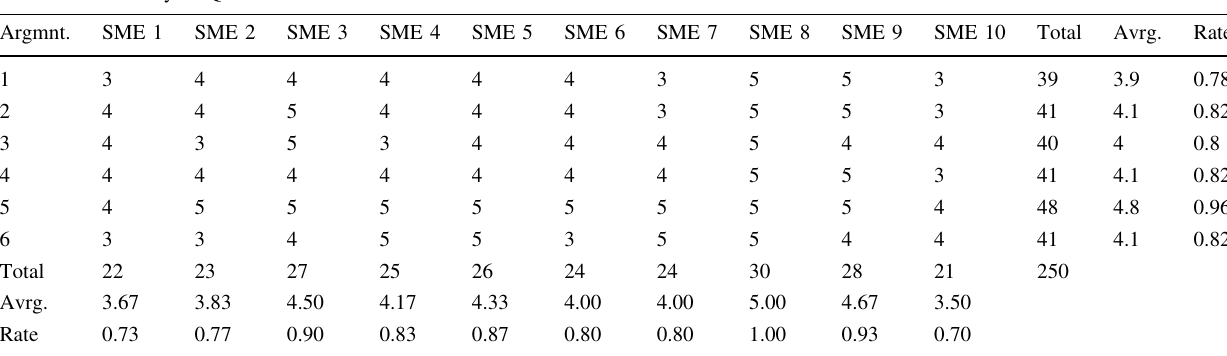
Table 26 Summary of Questionnaire 3 scores Argmnt.